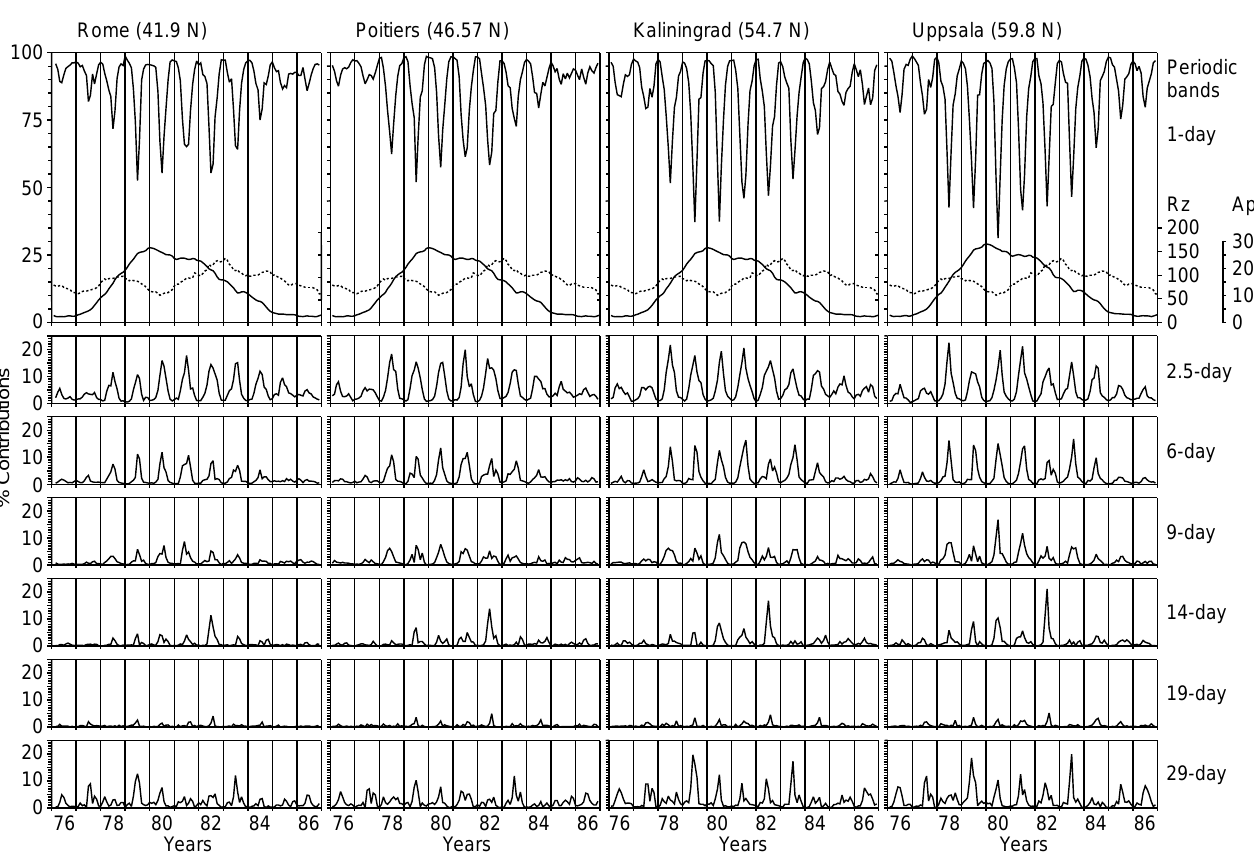
of sunspot numbers Rz ( thick line ) and geomagnetic activity index Ap ( dashed line ) are presented in the upper